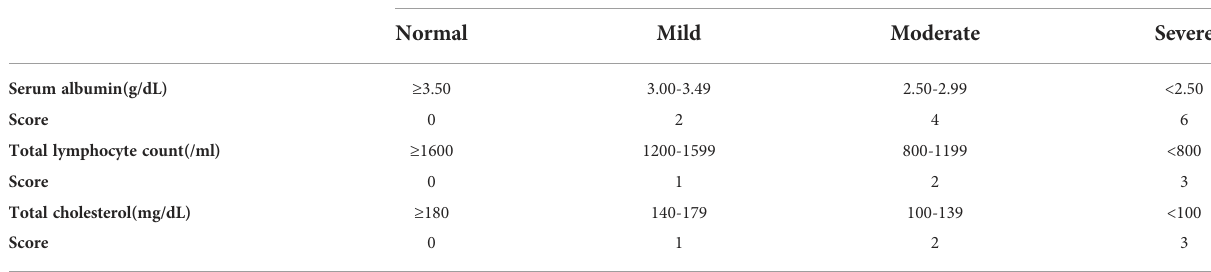
TABLE 1 The scoring criteria for the CONUT